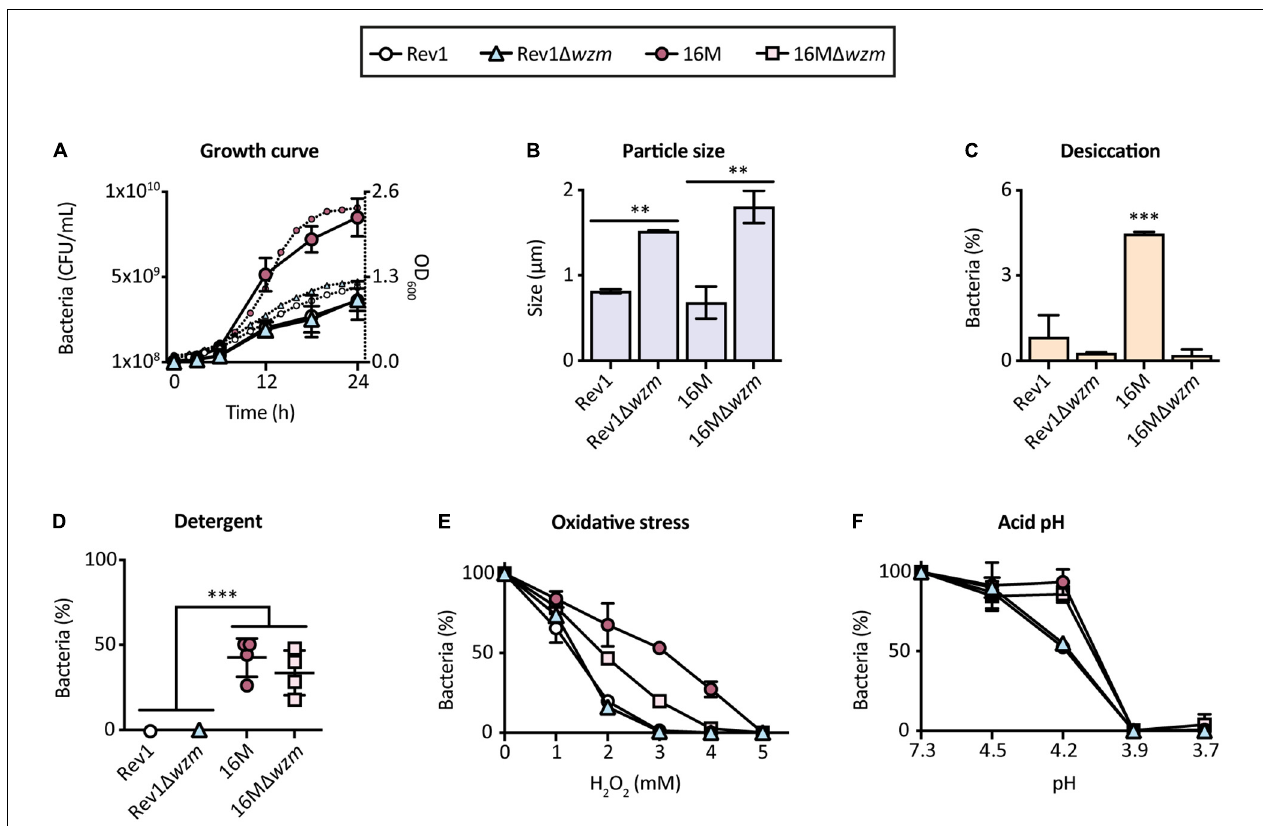
FIGURE 7 | Rev1 (cid:49) wzm has larger particle size than Rev1, but both perform similarly in the in vitro growth curves and environmental susceptibility. (A) Bacterial growth curves determined by the number of viable cells (CFU/ml; the left axe, large symbols) and medium absorbance (OD 600 ; the right axe, small symbols). (B) Particle size values measured by Zetasizer ( µ m). Percentage of bacterial inhibition by: (C) Desiccation, (D) Detergents (0.1% Triton X-100), (E) Oxidative (H 2 O 2 ), and (F) Acidic pH pressures, as models of stress encountered by Brucella in the natural environment and in the host niche. All results are expressed as the mean ± SD of at least three measures; strains Rev1, 16M, and 16M (cid:49) wzm were included as controls in all the experiments; the percentages of surviving bacteria (%) were determined with respect to the initial suspension. Fisher’s LSD test; ∗∗∗ p ≤ 0.001, ∗∗ p ≤ 0.01 vs. the indicated